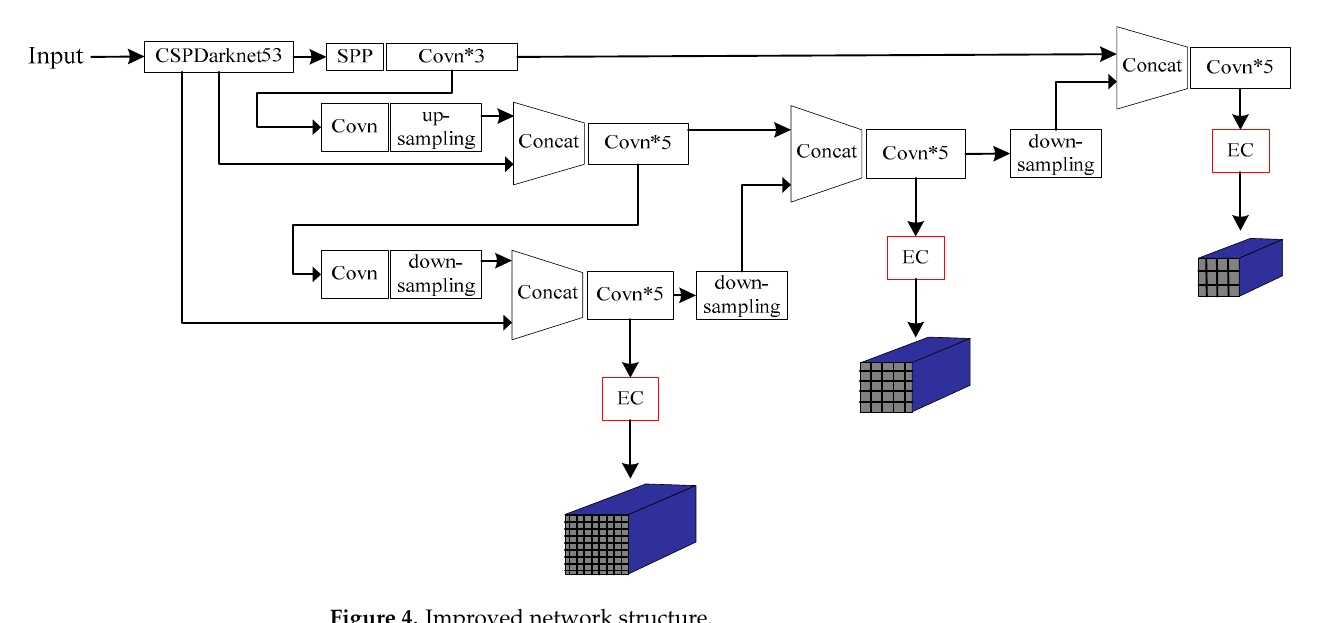
Figure 4. Improved network structure.